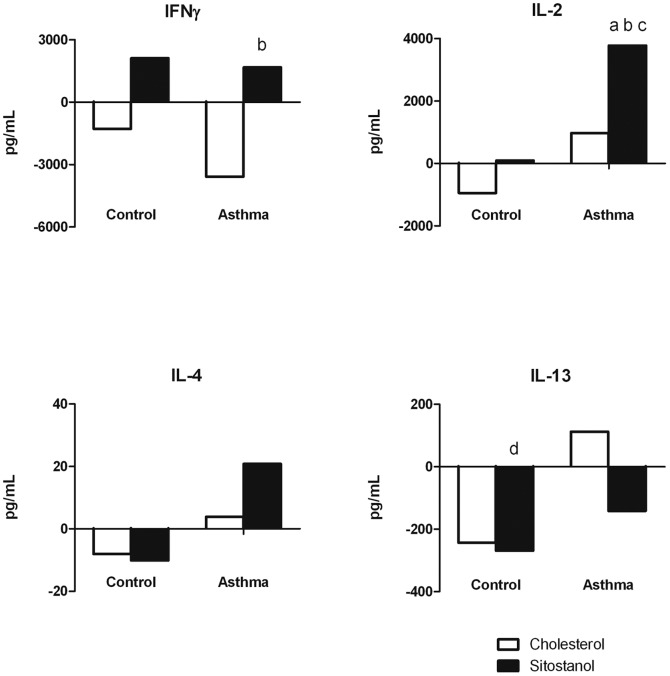
Effects of cholesterol and sitostanol on cytokine production in PBMCs.Sitostanol increased the IL-2 production in asthma patients when compared to cyclodextrin, cholesterol and healthy controls (p<0.05). Data are presented as median changes to the cyclodextrin condition. a = p<0.05 v cyclodextrin; b = p<0.05 v cholesterol; c = p<0.05 v healthy controls; d = p<0.10 v cyclodextrin.